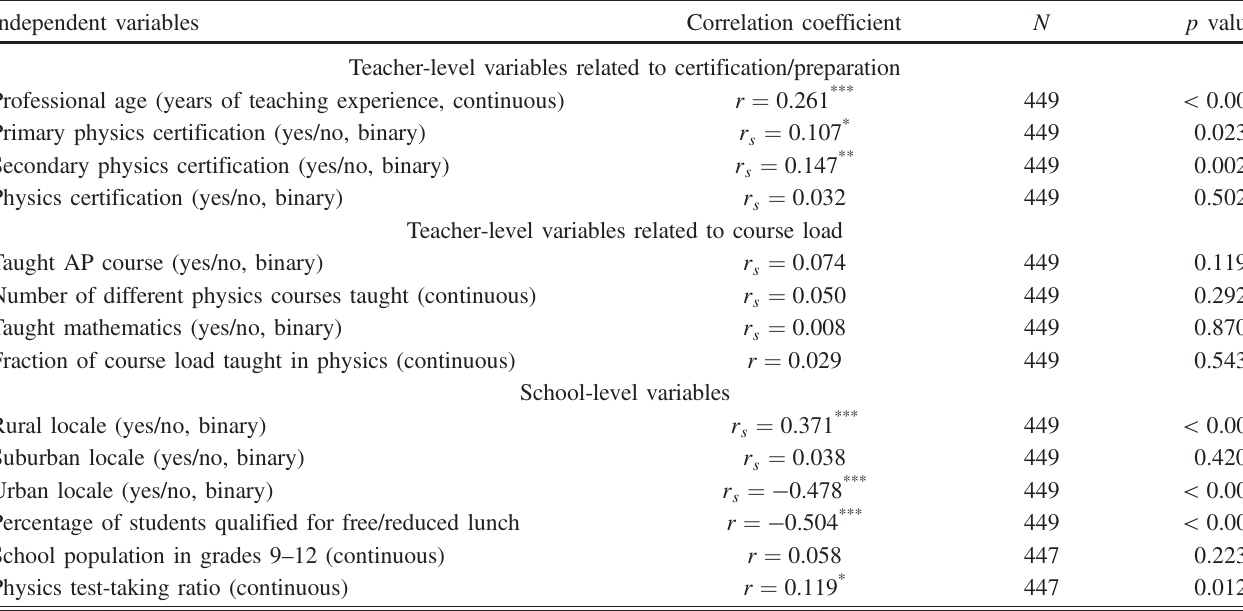
TABLE VIII. Potential predictors of physics